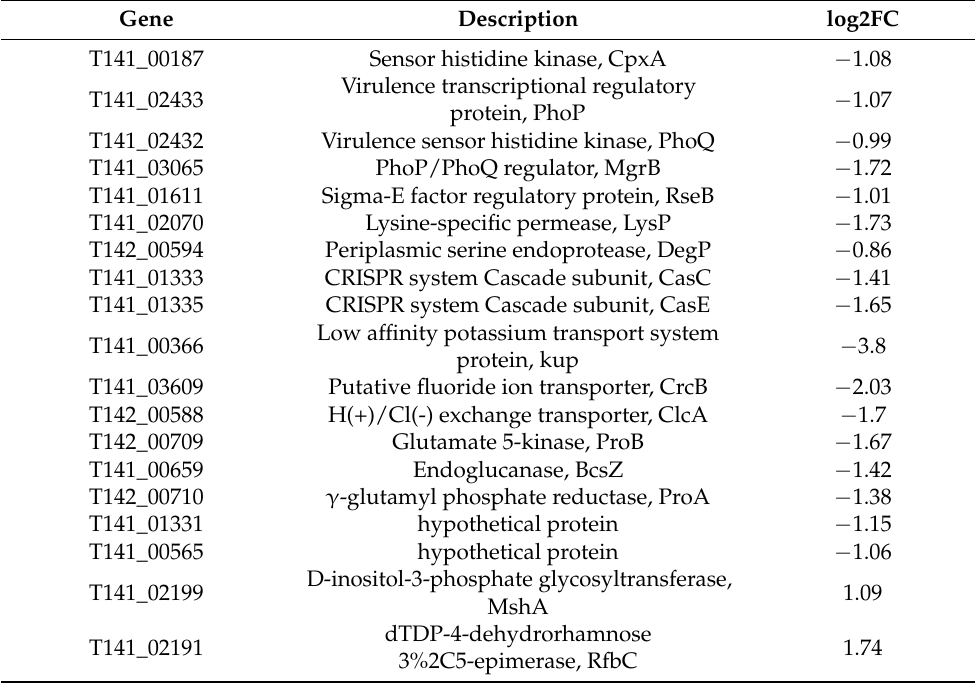
Table 4. Genes showing significantly different insertions under the acid condition identified by Tn-seq.